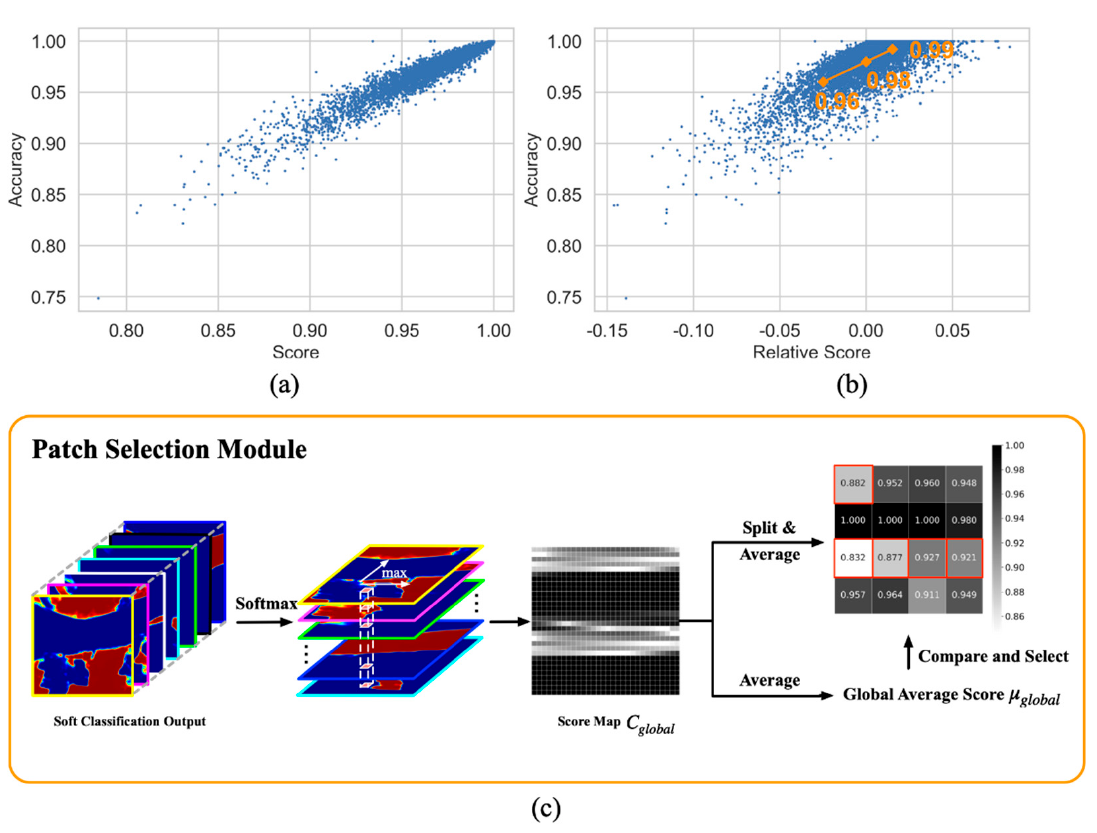
Figure 3. ( a ) The relationship between the score of local patch and its segmentation accuracy, where accuracy is the percentage of correctly predicted samples; ( b ) Relative score of local patch and its accuracy, where the relative score is defined as µ global − µ ; ( c ) PSM module. PSM selects the local patch that requires reinforcement based on the global image’s soft classification output.